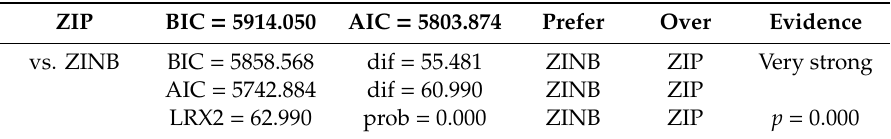
Table 3. Tests and Fit